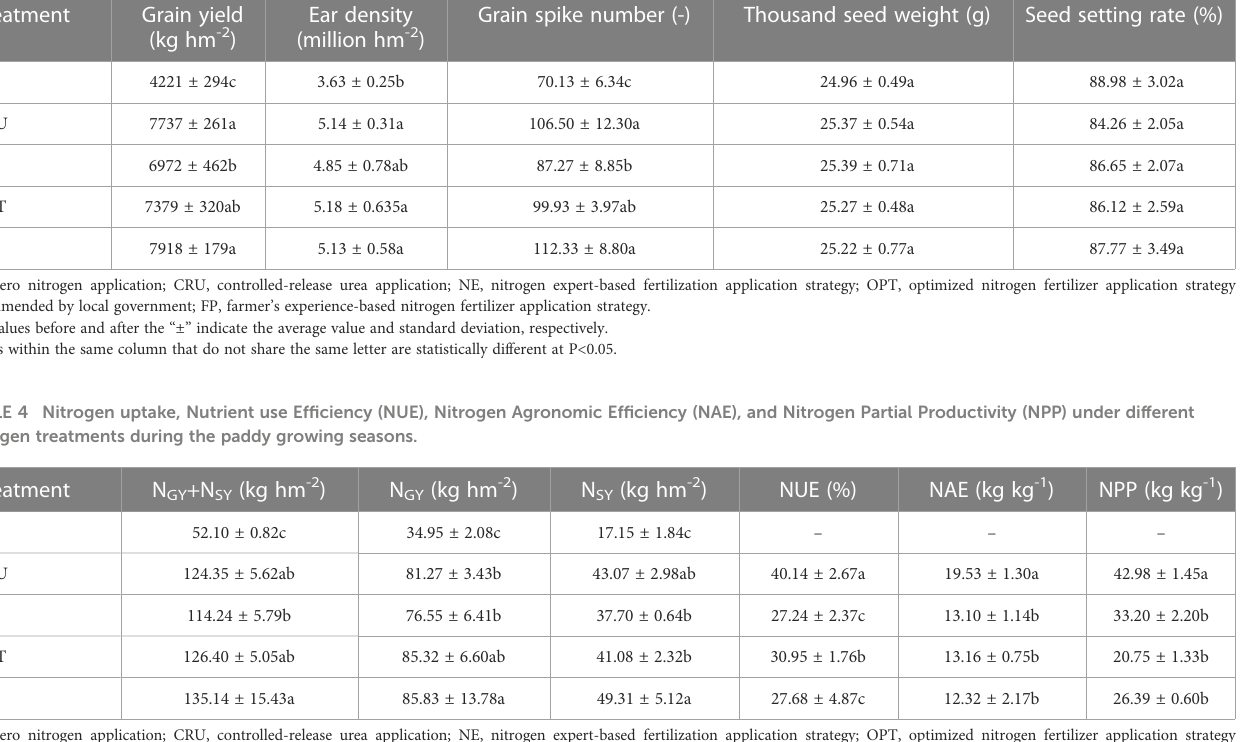
TABLE 3 The grain yield and yield components under different nitrogen fertilizer treatments after harvest. Treatment